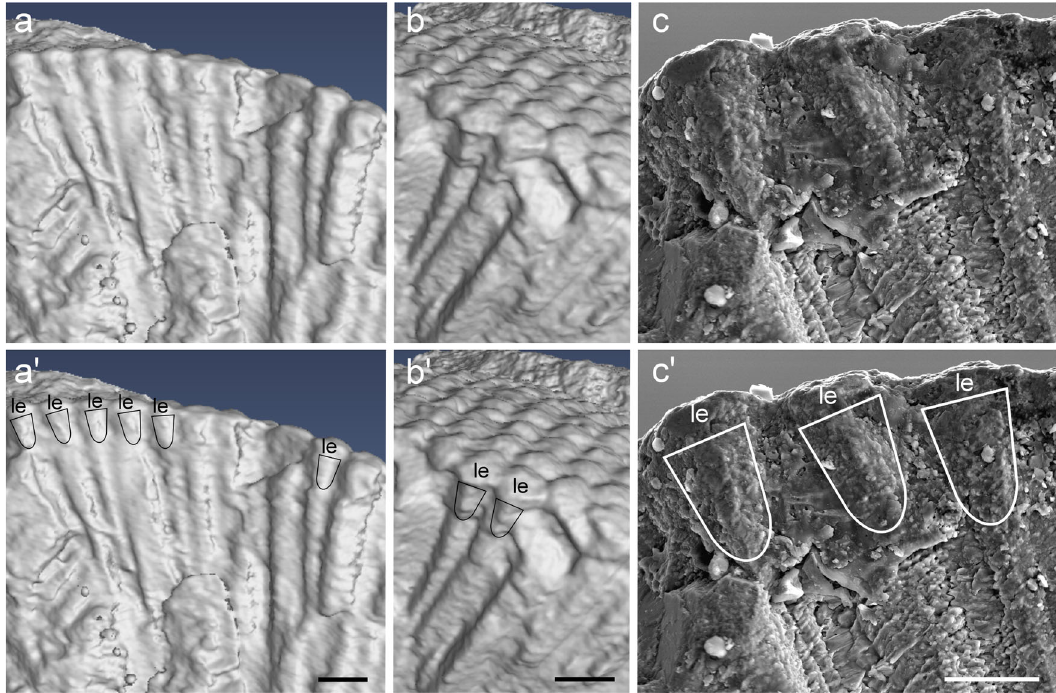
Fig. 2 The compound eye of the Devonian trilobite Archegonus warsteinensis (Museum für Naturkunde, Berlin: MB.T 7303). The upper row ( a – c ) shows the compound eye structures using different techniques of visualization. a , b different perspectives using surface rendering of a μ -CT scan of different parts of the fractured eye. c An SEM picture of a part of image a slightly magni fi ed. In all images, super fi cial lenses (le) (see a ’– c ’ ) are visible. Underneath them are cone-like structures that we interpret as fossilized crystalline cones. The cones are highlighted with black or white lines in the lower row ( a ’– c ’ ). Scale bars: 100 μ m ( a ’– b ’ ), 50 μ m ( c ’ ), they also refer to ( a , b ) and ( c